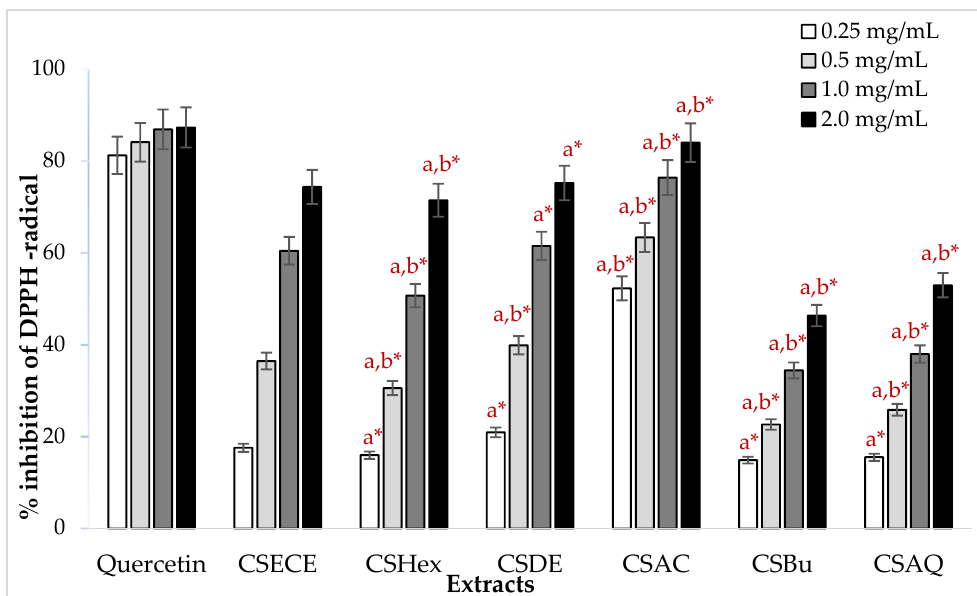
Figure 3. DPPH test: Histograms, expressed as a percentage of inhibition (%), illustrating the antioxidant activity of the standard, the crude extract (CSECE) and its fractions at different concentrations, a and b mean statistically different from standard and CSECE respectively for the same concentration, * indicates significance ( p < 0.05). The fractions: CSHex: hexane, CSDE: diethyl ether, CSAC: ethyl acetate, CSBu: n-butanol, CSAQ: aqueous.